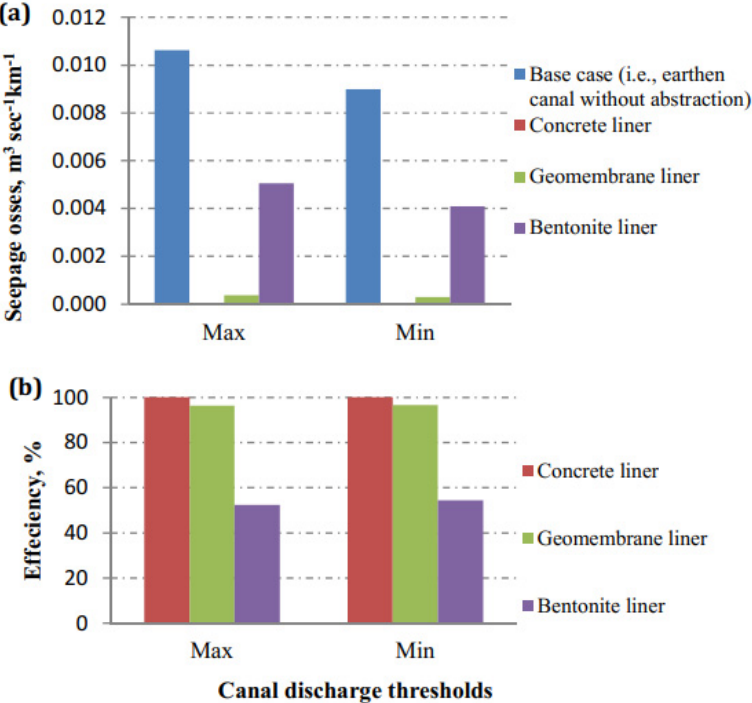
Figure 7. Canal linings of different materials without extraction with ( a ) seepage losses and ( b ) effi- ciency.